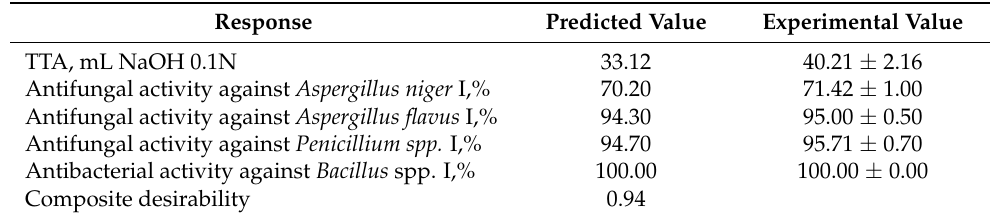
Table 5. Predicted versus experimental results for the optimized sourdough. Inhibition ratios obtained according to Equation